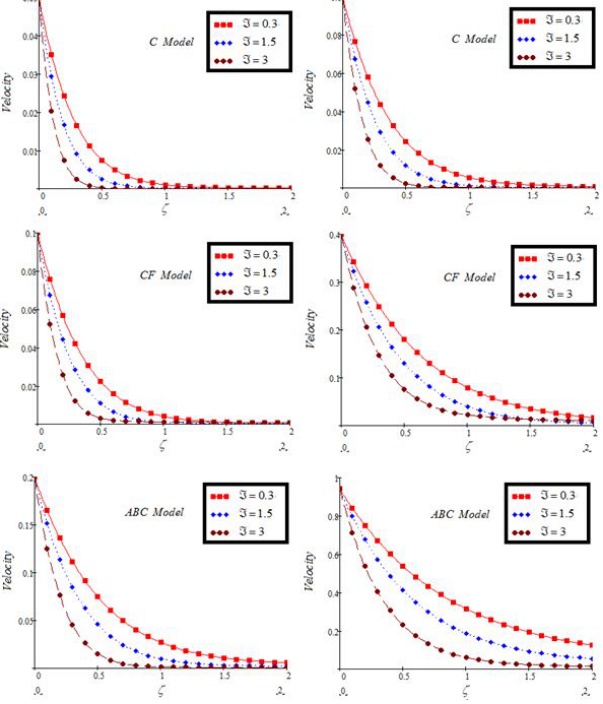
Figure 9: Velocity profile for FD’s with variation of (cid:61) and Pr = 2, M = 0.5, ε = 0.4